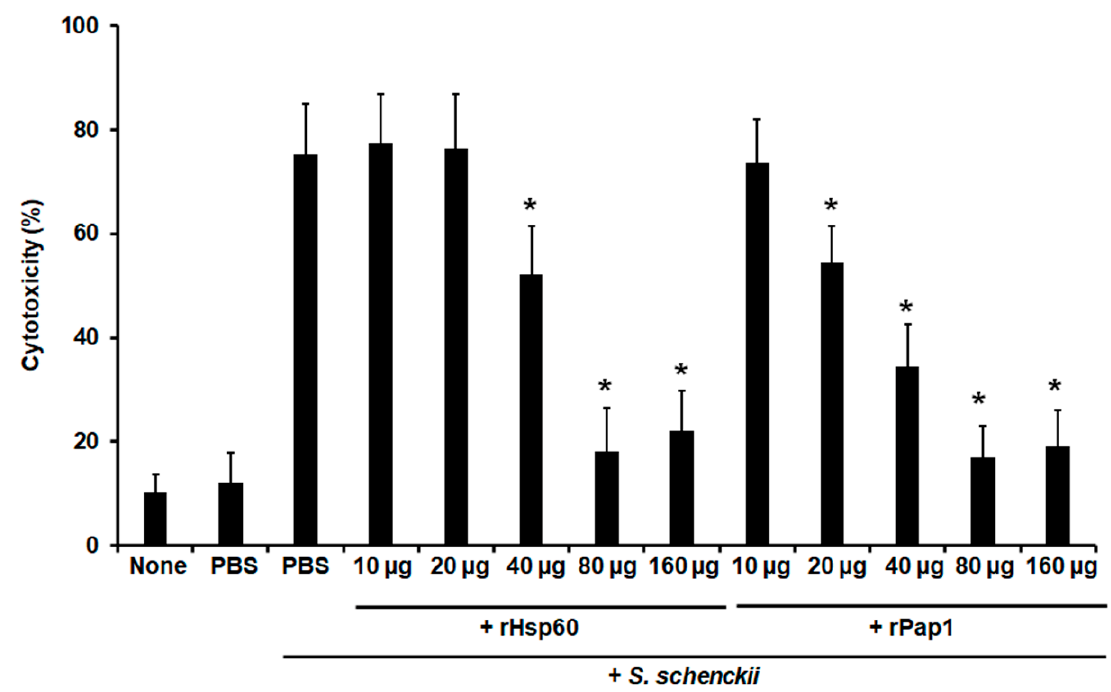
Figure 6. Effect of recombinant Hsp60 and Pap1 on the cytotoxicity associated to Galleria mellonella killed by Sporothrix schenckii. G. mellonella larvae were inoculated with either phosphate-buffered saline (PBS) or the indicated amount of rHsp60 or rPap1 and incubated for 5 days at 37 ◦ C. A lethal S. schenckii inoculum of 1 × 10 5 yeast-like cells was injected into larvae and incubated at 37 ◦ C for 24 h, and the cell-free lactate dehydrogenase activity was quantified in the hemolymph. PBS, control group inoculated and challenged with PBS. PBS + S. schenckii , animal group inoculated with PBS and challenged with 1 × 10 5 yeast-like cells. None, noninoculated animal group. Results are means ± SD of three independent experiments performed by duplicate. * p < 0.05 when compared to PBS + S. schenckii. Table 4. Colony-forming units, hemocyte count, phenoloxidase, and melanin production in Galleria mellonella larvae challenged with Sporothrix schenckii yeast-like cells. Inoculated